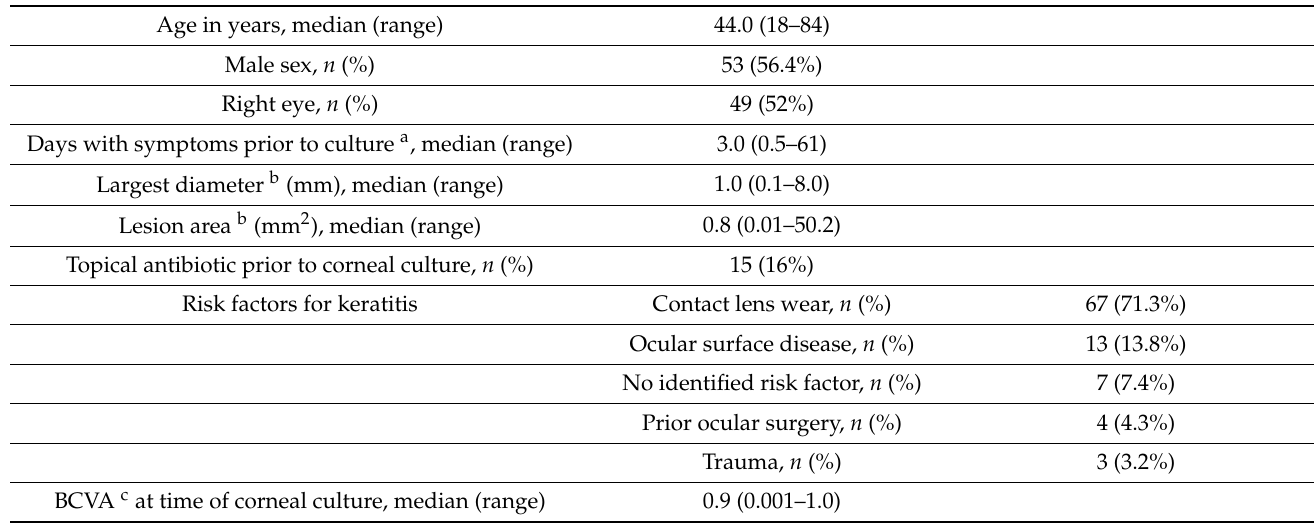
Table 1. Background data on the study cohort treated for infectious keratitis ( n = 94